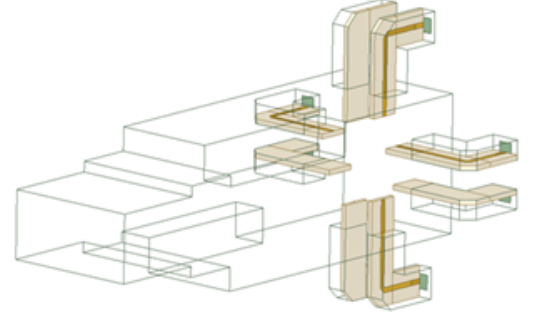
FIGURE 2. Longitudinal and Transverse Probes.